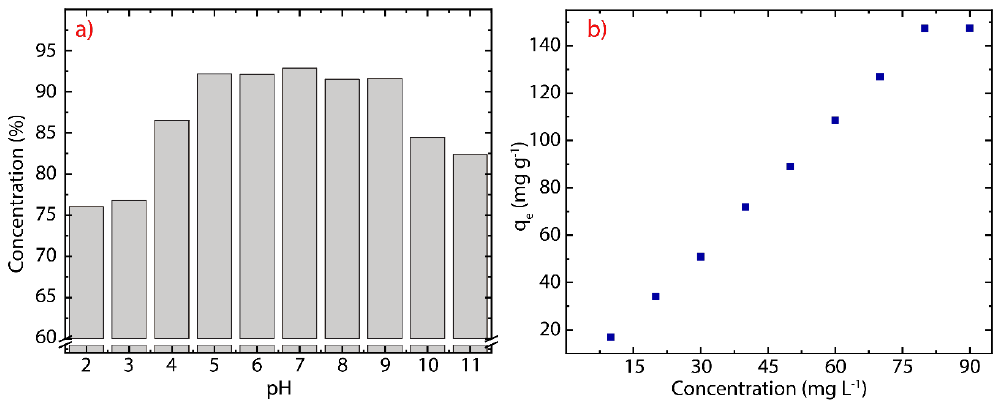
Figure 7. ( a ) Adsorption of MB on rGO as function of the pH ( C 0 = 100 mg L − 1 , W = 200 mg, T = 298) and ( b ) effect of the initial concentration on the adsorption process ( C 0 = 10 – 90 mg L − 1 , W = 200 mg, V = 50 mL).